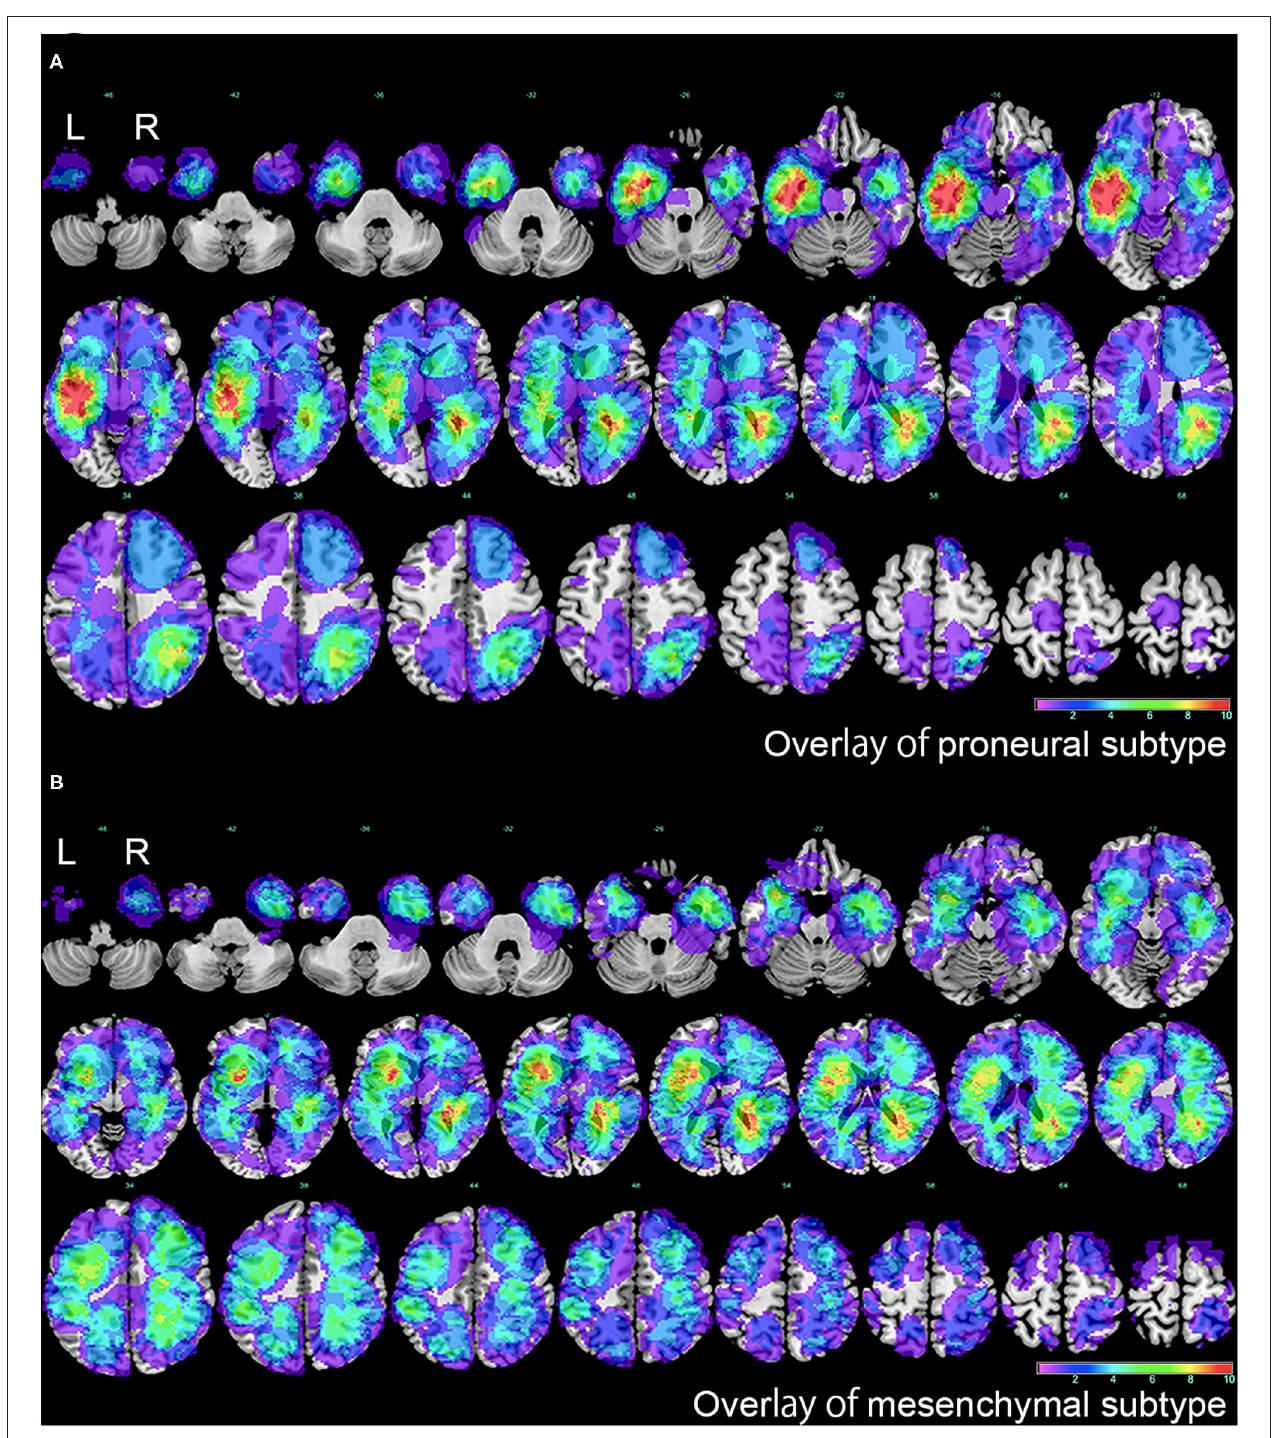
FIGURE 3 | The overlap of proneural and mesenchymal subtypes of GBM. (A) The overlap of proneural subtype of GBM. The color scale indicated the amount of the VOIs overlap, from violet (1 case) to red (more than 10 cases). (B) The overlap of mesenchymal subtype of GBM. The color scale indicated the amount of the VOIs overlap, from violet (1 case) to red (more than 10 cases). L represented left side, and R represented right side.